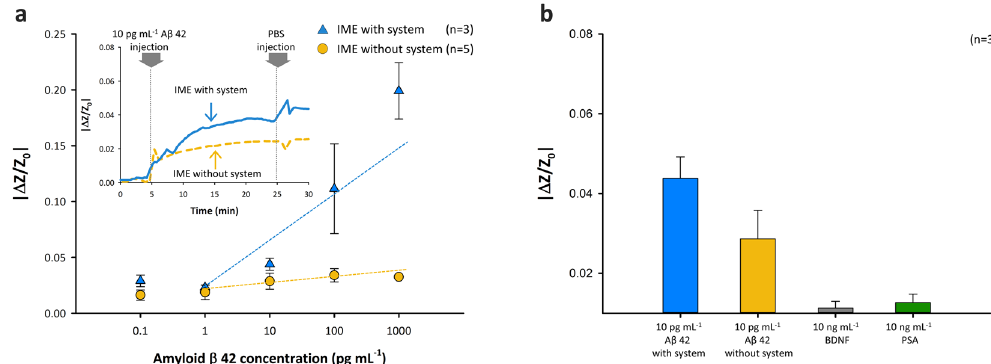
Figure 3. Sensing test for A β detection. ( a ) Sensitivity test of various A β concentrations and real-time detection by the IME with and without the designed system. ( b ) Selectivity tests using impedance changes for 10 ng mL − 1 PSA, 10 ng mL − 1 BDNF, and 10 pg mL − 1 A β -injected